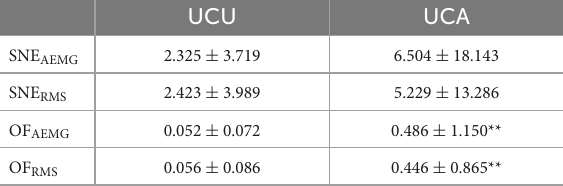
TABLE 2 Surface Electromyography parameters of bilateral biceps brachii of patients with stroke. UCU